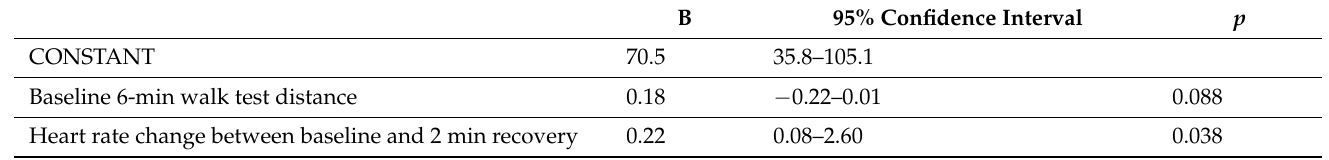
Table 2. Multiple linear regression (backwards method) model for predictors of changes in 6 min